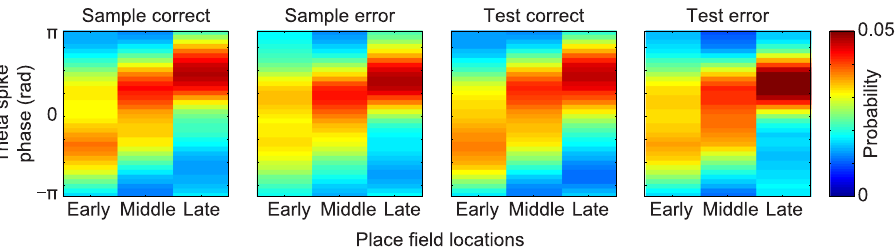
Fig. 5 Place cells active at the beginning of the trajectory toward the reward fi red at earlier theta phases in correct trials than in error trials. The probability of observing a spike at different theta phases for spikes from place cells with fi elds located at early, middle, or late locations in the trajectory is shown for each trial type (2-way ANOVA Harrison – Kanji test for population means of circular data, effect of trial type x cell category interaction: χ 2 (6) = 21.8, p = 0.001, n = 19428 spikes; for comparison of theta phases of “ Early ” cells between correct and error trials, 2-way ANOVA Harrison-Kanji test for population means, signi fi cant main effect of trial type (i.e., correct vs. error) for cells that fi red early in the sequence: χ 2 (2) = 7.8, p = 0.02, n = 8044 spikes). Phase estimates were only obtained from spikes within the place cell sequences detected from 10 to 5 locations before the